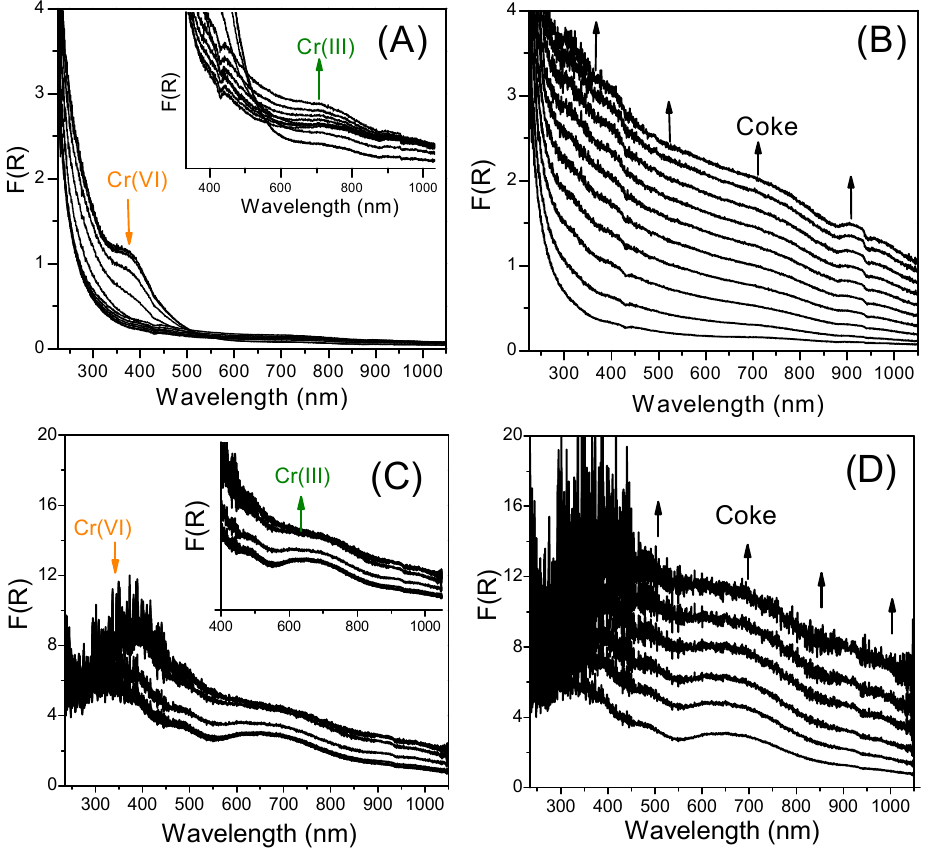
Figure 5. UV-Vis DRS spectra recorded during first 10 min ( A , C ) and between 10 and 240 min ( B , D ) of process over the Cr1/Al 2 O 3 -n and Cr20/Al 2 O 3 -n catalysts. Reaction conditions: T = 550 °C; m cat. = 200 mg; WHSV = 1.2 h − 1 ; Feed gas composition C 3 H 8 :He =1:14; Total flow rate = 30 cm 3 ·min − 1 .